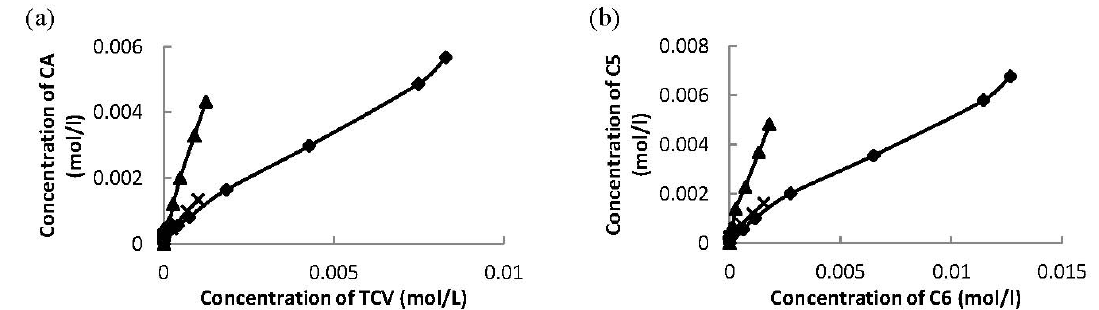
Figure 7. (a) Concentration of campholenic aldehyde versus concentration of trans -carveol and (b) concentration of C5 products (sum of concentration of campholenic aldehyde and fencholenic aldehyde) versus concentration of C6 products (sum of concentration of trans -carveol and 2-methyl-5-(propan-2-ylidene)cyclohex-2-enol) over 32 wt %